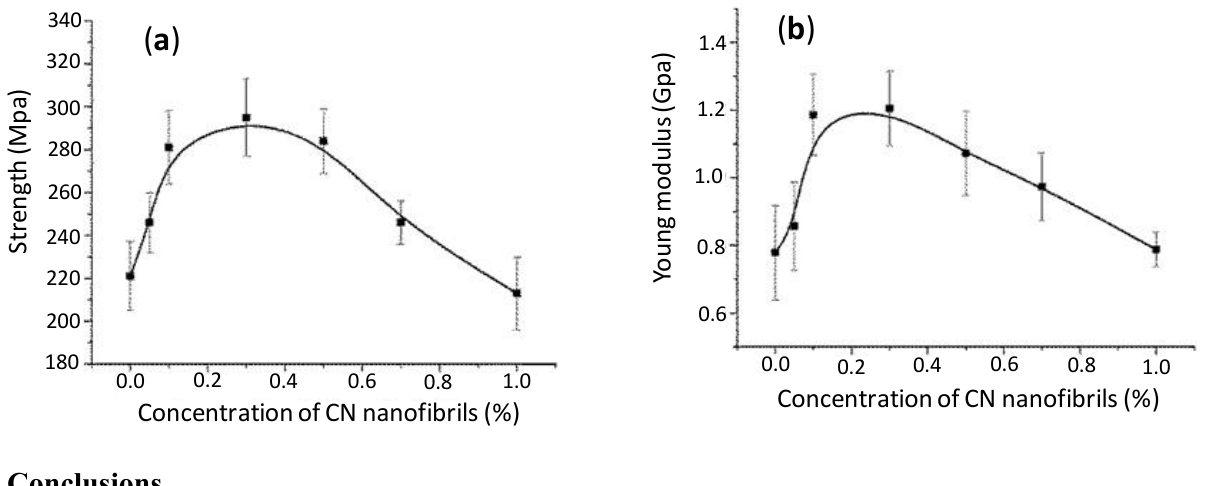
Figure 20. Dependences of tensile strength ( a ) and Young modulus ( b ) of the chitosan/CN composite fibers on the content of the chitin